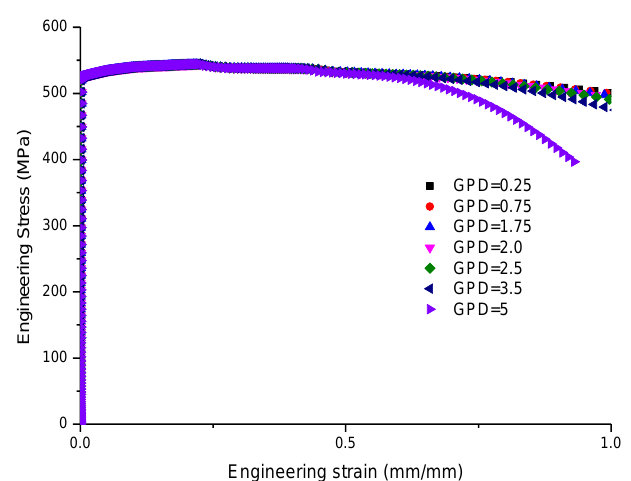
Figure 13. Comparison of engineering strain-engineering stress curves for different gauge point displacements.